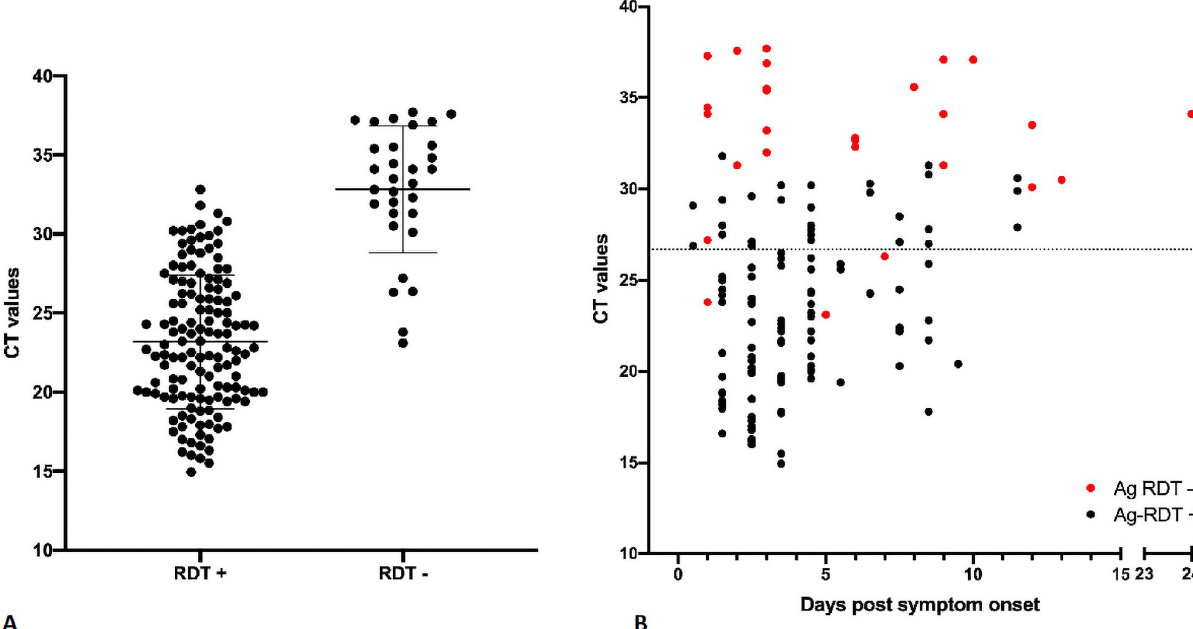
Fig 1. SARS-CoV-2 detection by Panbio ™ antigen rapid test using OPS compared to the reference RT-qPCR detection method using NPS. A. Ct values, viral load and Ag-RDT results for 166 RT-PCR-positive individuals. Horizontal bars represent median and standard deviation. Dotted line: Ct value of 26.7 or 1E6 SARS-CoV-2 RNA copy numbers/mL. Note: Two samples were excluded because of low viral load (positive signal in ORF1 assay but negative signal in E-gene target, thus excluded from the graph. Both samples gave a negative RDT result). B. Ct values, viral load, days post symptom onset and Ag-RDT results for 139 patients for which information on day of symptom onset was available. Dotted line: Ct value of 26.7 or 1E6 SARS-CoV-2 RNA copy numbers/mL.